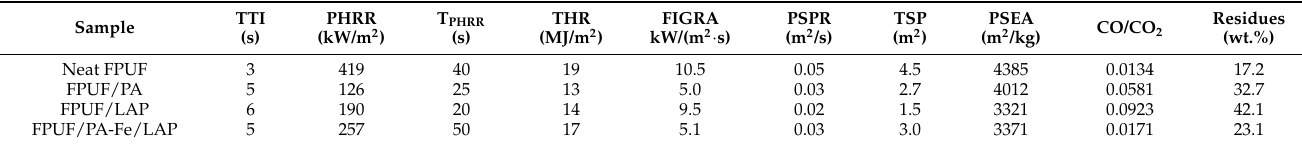
Table 4. The detailed data from CCT.